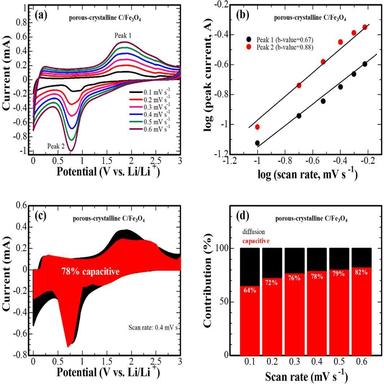
CV curves of the porous-crystalline C/Fe3O4 microspheres (a) at different scan rates; relationship between log(scan rate) and log(peak current) at anodic and cathodic peaks (b); capacitive (red) and total (black) current at a scan rate of 0.4 mV s1 ; capacitive contributions to charge storage at different scan rates. (For interpretation of the references to colour in this figure legend, the reader is referred to the web version of this article.)